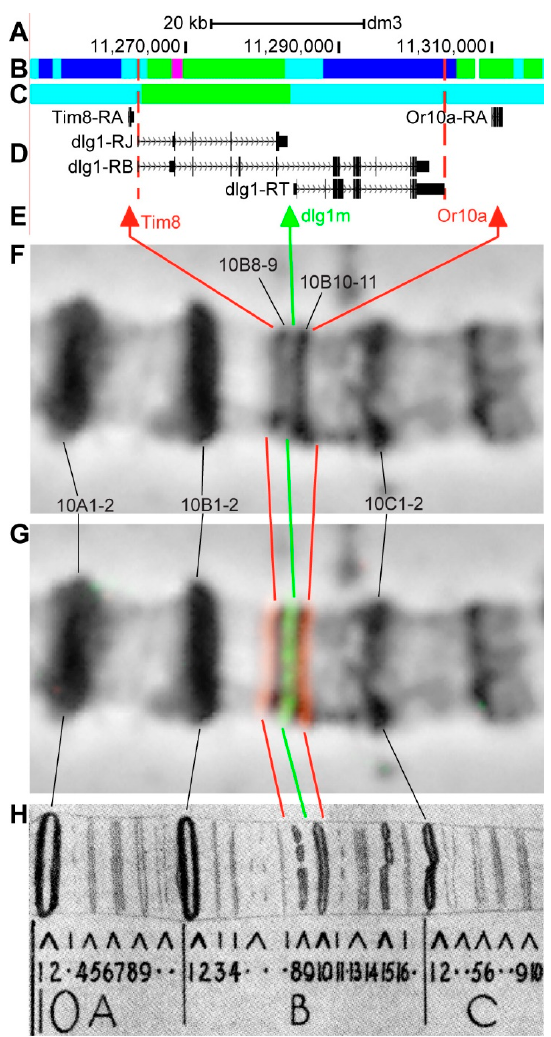
Figure 15. Localization of the dlg1 gene in the 10B region (the gene is bound by red dotted lines). (A) the scale (kb) and genomic coordinates (bp); (B) the four chromatin-state model [39]; (C) the chromatin condensation level model [32]; (D) genes location (arrow lines show the gene orientation and black bars indicate the location of gene exons); (E) probes location; (F) phase-contrast micrograph of the region; (G) combined FISH signals; and, (H) C. Bridges’ chromosome map [25].